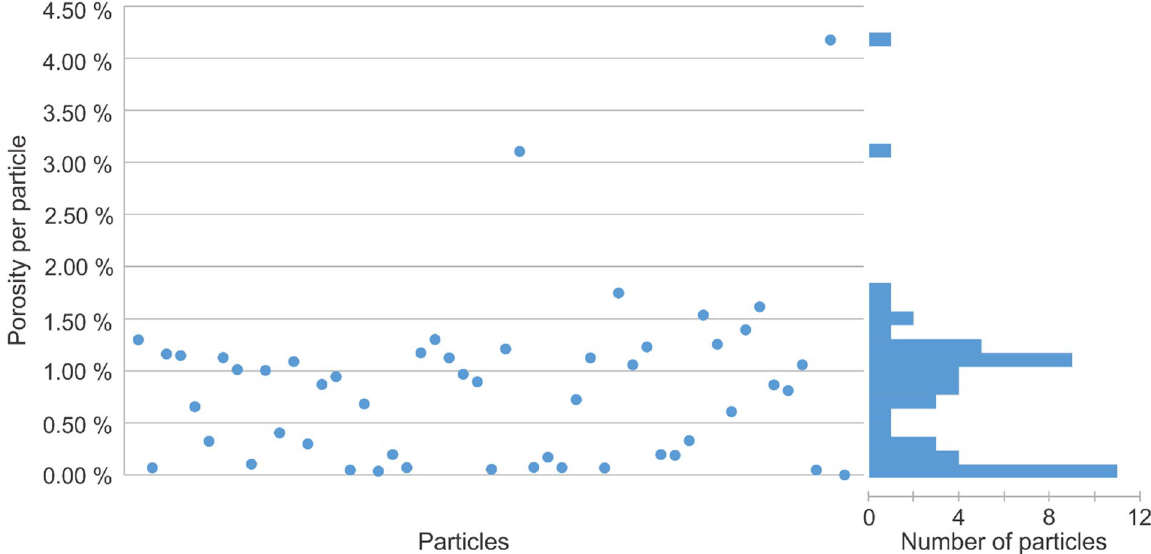
Figure 7. Left: scatter plot of the resolved porosity per particle. Right: histogram of particles per porosity. The bimodal distribution of porosities enabled to classify the particles in two groups.